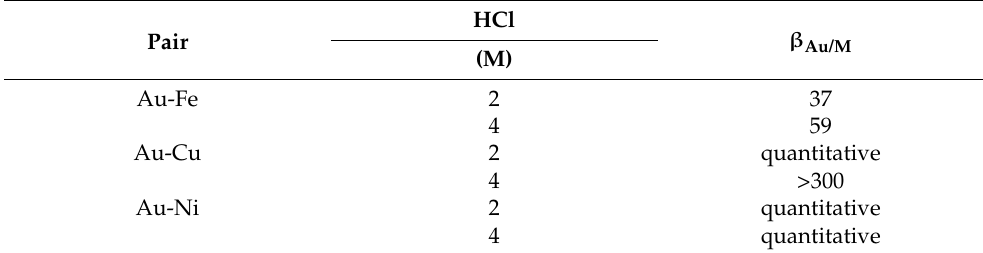
Table 4. Values of β for the present system.